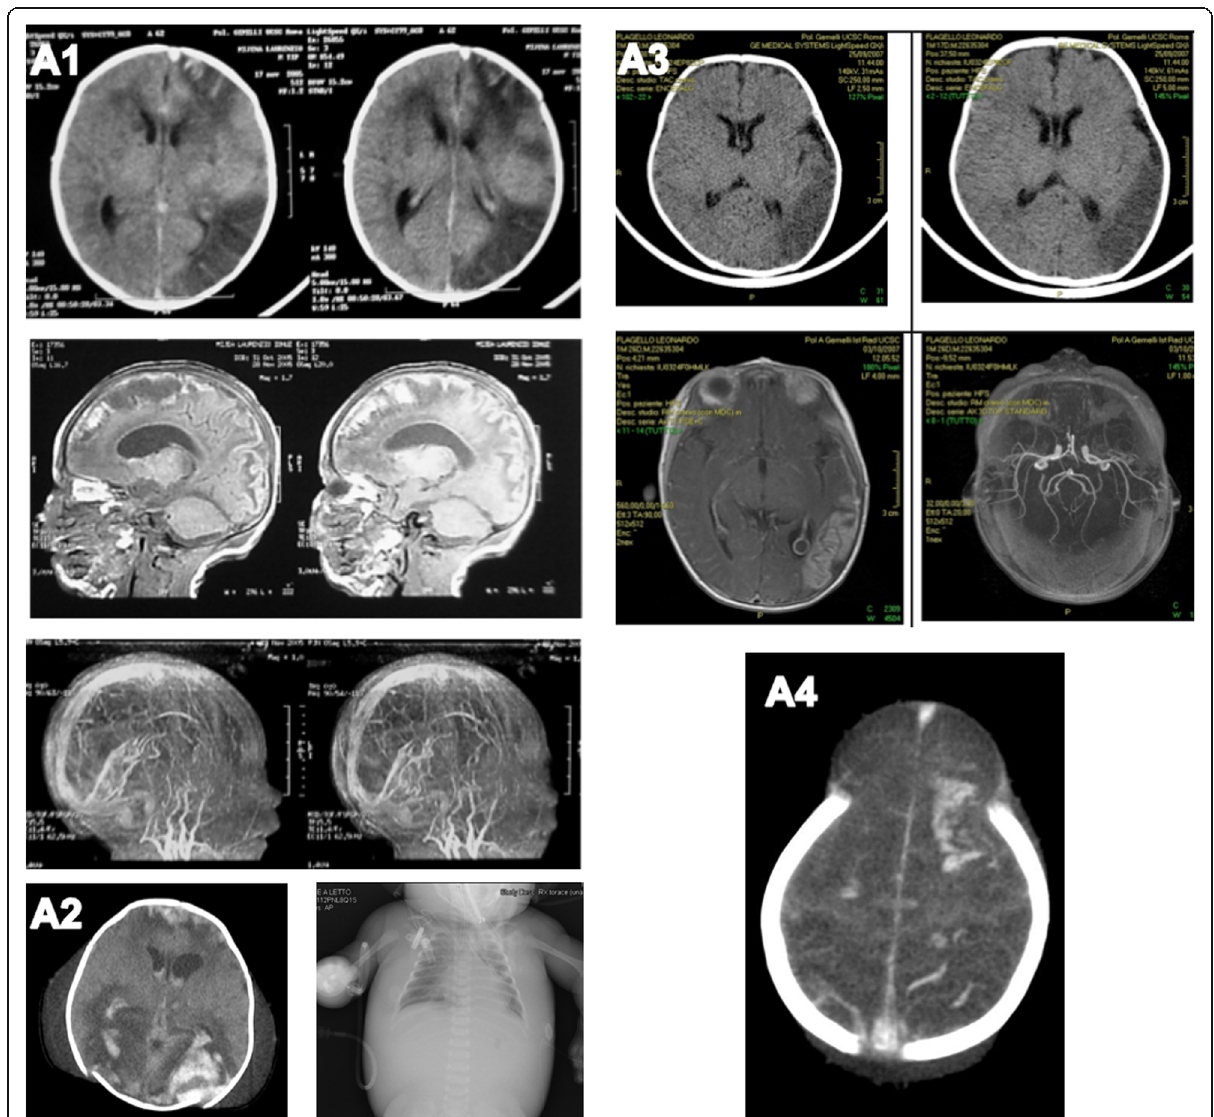
Fig. 1 A – D Brain imaging showing different patterns of cerebrovascular